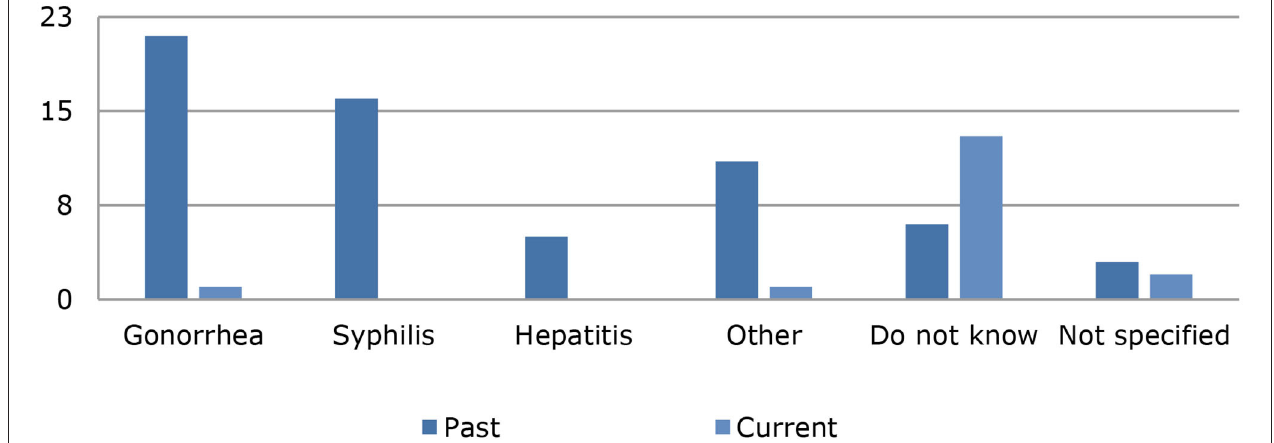
FIGURE 5 | Current and past sexually transmitted diseases among chemsex users.